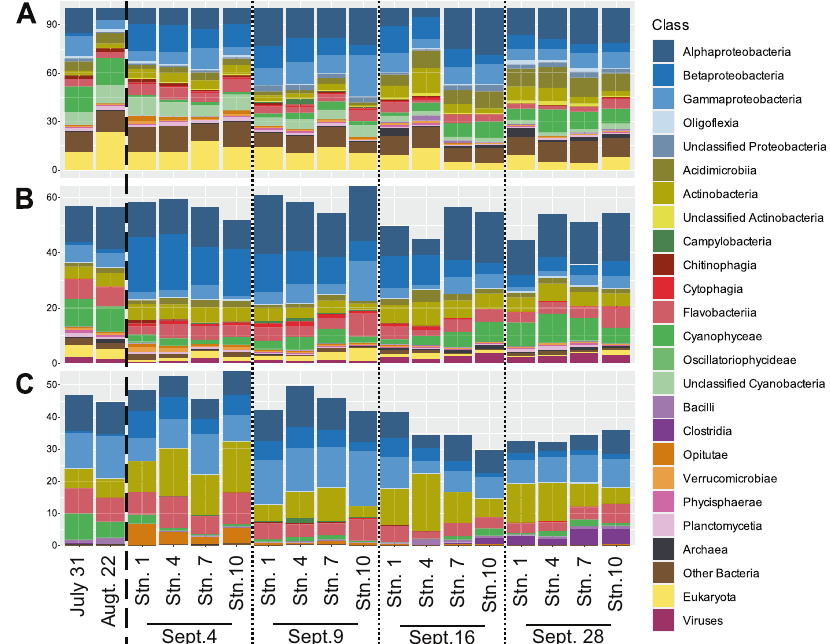
Fig. 2 Changes in the microbial community composition of Galveston Bay following Hurricane Harvey. Stacked bar histogram showing the relative abundance of major microbial groups at the class level identi fi ed by 16S and 18S rRNA extracted from the metagenomic data ( A ), the complete gene pool ( B ), and the MAGs generated from the co-assembly ( C ). The July 31 and August 22 samples were taken before Hurricane